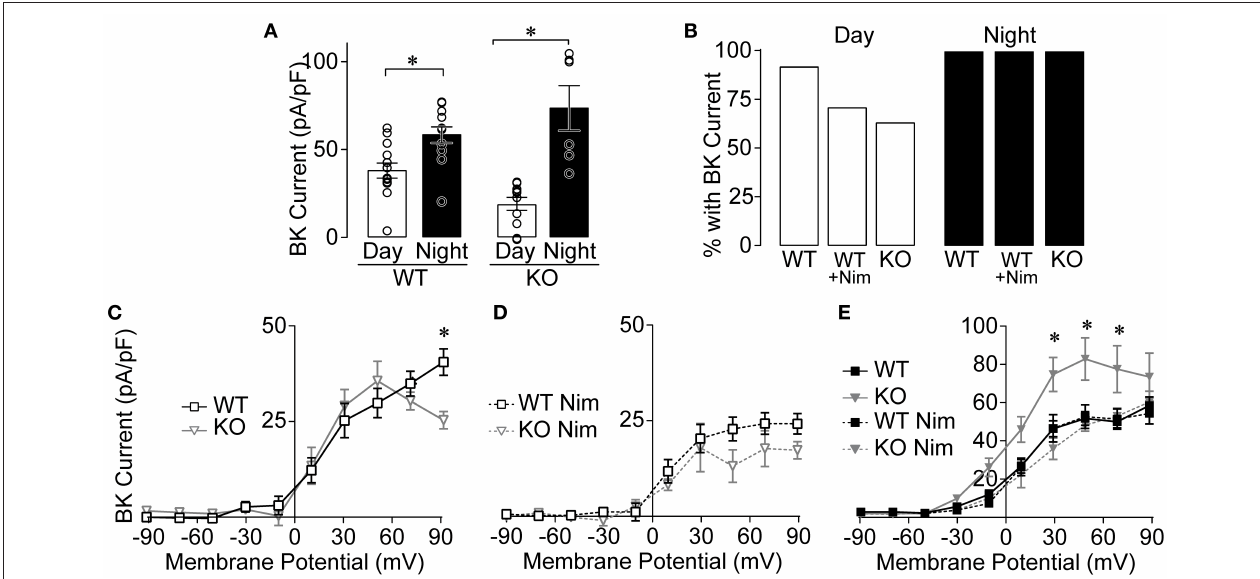
FIGURE 4 | BK currents from Ca V 1.3 WT and Ca V 1.3 KO SCN during the day and night. Paxilline-sensitive macroscopic BK currents were recorded as in Figure 1 . (A) Summary of BK current densities at + 90mV recorded from Ca V 1.3 WT and Ca V 1.3 KO neurons during the day and night. BK currents were increased at night for both Ca V 1.3 WT ( P = 0.004) and Ca V 1.3 KO ( P = 0.007) compared to the day. * P < 0.05, unpaired Welch’s t tests. (B) Percentage of SCN neurons with BK current in Ca V 1.3 WT and Ca V 1.3 KO neurons recorded in control conditions or in 10 µ M nimodipine (Nim) during the day and night. The number of neurons exhibiting BK currents was not different between Ca V 1.3 WT and Ca V 1.3 KO ( P = 0.14, Fischer’s exact test). N’s: Ca V 1.3 WT, 12/13 (cell with BK current/total number recorded); Ca V 1.3 WT Nim, 10/14; Ca V 1.3 KO, 7/11 and night: Ca V 1.3 WT, 12/12; Ca V 1.3 WT Nim, 13/13; Ca V 1.3 KO, 6/6. (C,D) Current-voltage plot for normalized BK current densities from Ca V 1.3 WT and Ca V 1.3 KO neurons in control conditions (C) and after application of Nim (D) during the day. Ca V 1.3 WT BK currents